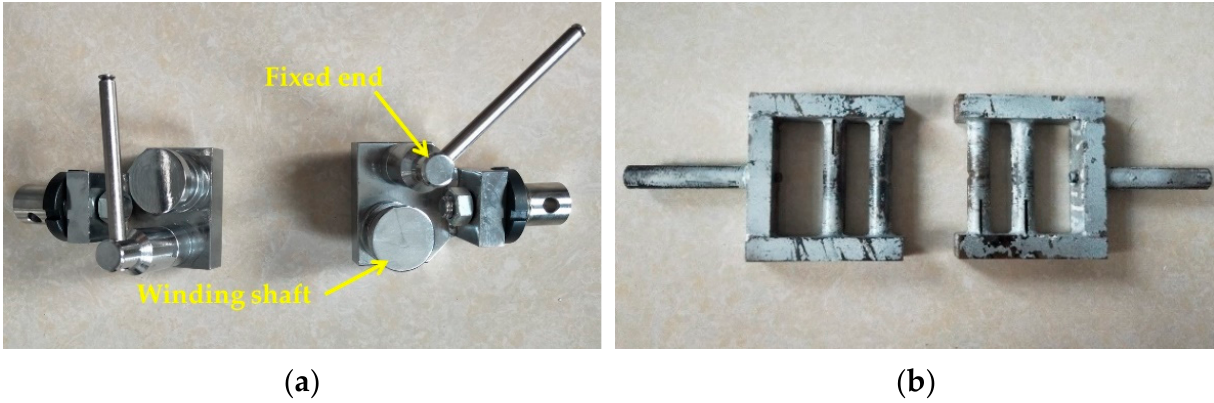
Figure 4. Pictures of the special fixture for the test: ( a ) special fixture for winding the steel wire; ( b ) special fixture for winding the reinforced belt.